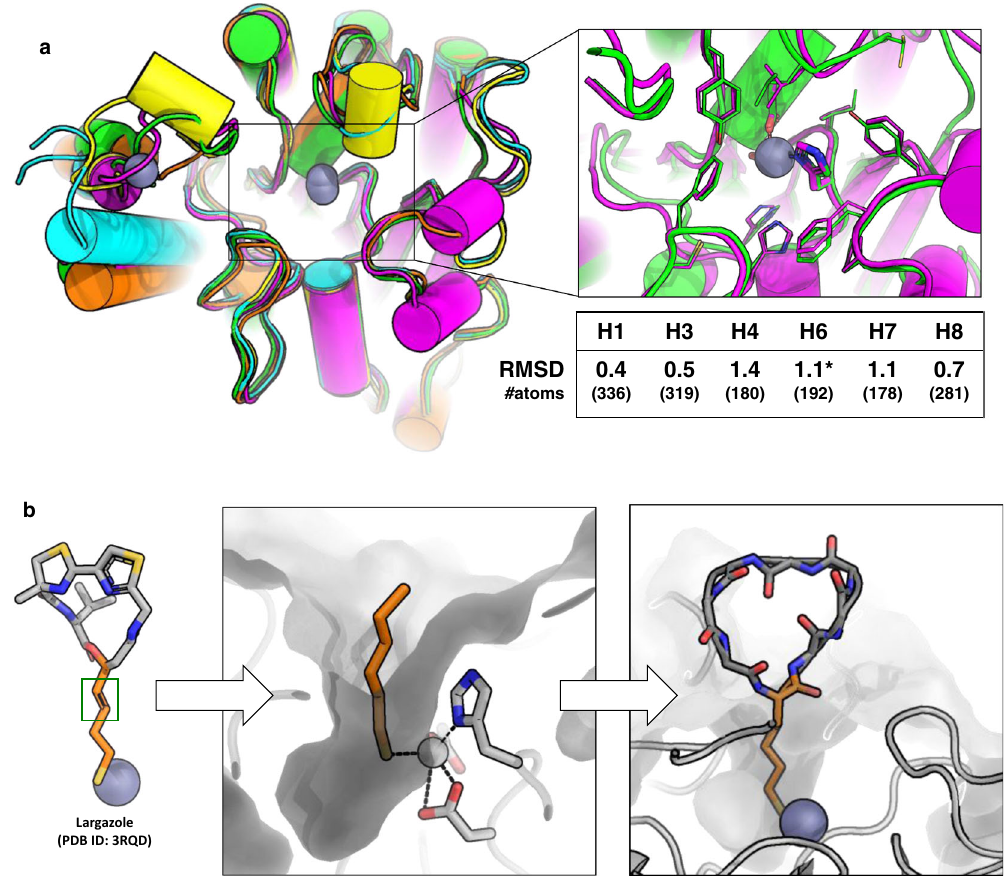
Fig. 1 Anchor extension based design of macrocycles targeting HDAC2. a Top left: Overlay of crystal structures of several HDACs showing the secondary structure elements adjacent to the active site (box on left) and their RMSD to HDAC2 (H1 = HDAC1, H3 = HDAC3, H4 = HDAC4, H6 = HDAC6, H7 = HDAC7, H8 = HDAC8). RMSD is calculated over the conserved secondary structure elements shown in the fi gure. Number of atoms in the aligned region is mentioned in the table. HDAC2 (green, PDB ID: 5IWG), HDAC4 (cyan, PDB ID: 2VQO), HDAC6 (magenta, PDB ID: 6R0K), HDAC7 (yellow, PDB ID: 3C0Z), HDAC8 (orange, PDB ID: 3SFF). All structures shown here are human variants except HDAC6 (shown by an asterisk), which is the homolog from Danio rerio . The inset on top right shows the overlay of the active site residues of HDAC2 (green) and HDAC6 (magenta). The residues coordinating the active site Zn (gray sphere) are shown in sticks. b Schematic representation of anchor-extension approach. The SHA (2S-2-amino-7-sulfanylheptanoic acid) anchor was inspired by the long tail of the HDAC-binding small molecule Largazole and modeled in HDAC2 pocket. A double bond in Largazole (green box) was replaced by a single bond in SHA to allow synthesis. Low-energy bound conformations were sampled using molecular dynamics simulations and served as starting points for designing new macrocycle